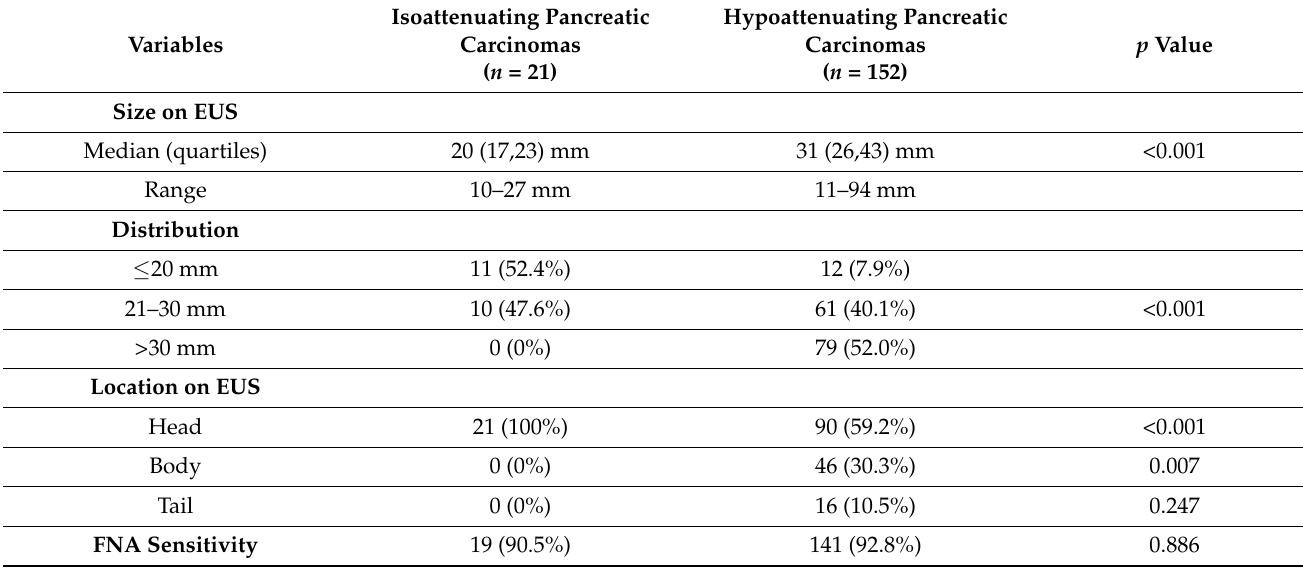
Table 4. Differences between isoatenuating and hypoattenuating pancreatic carcinomas on